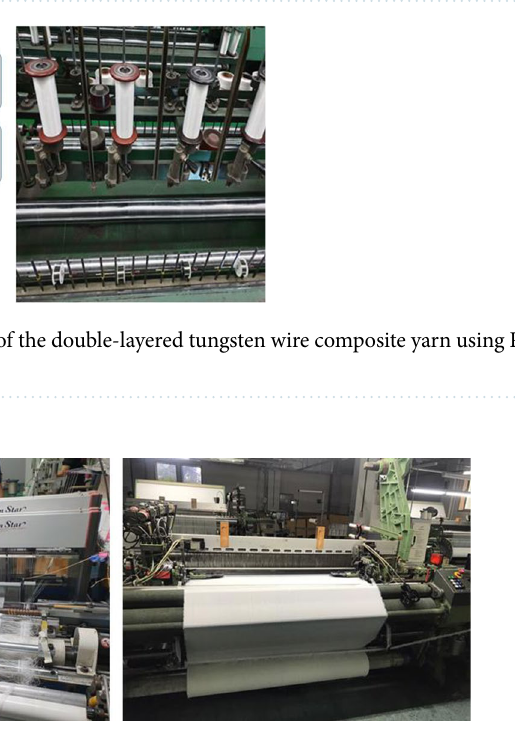
Figure 4. Shielding fabric weaving process conducted using an HTVS 8/S20